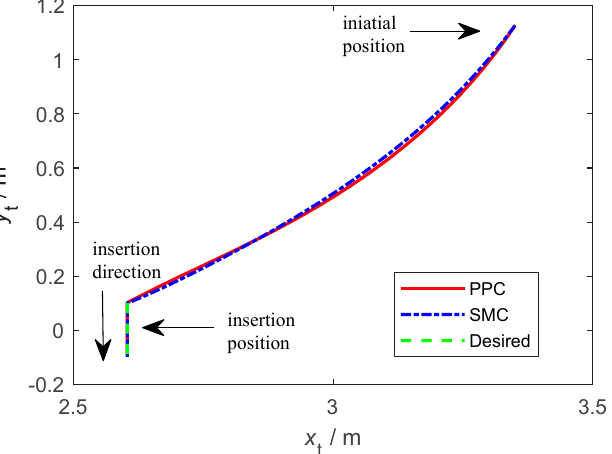
Figure 6. Space robot end X&Y-direction trajectory tracking curve of on-orbit insertion operation.